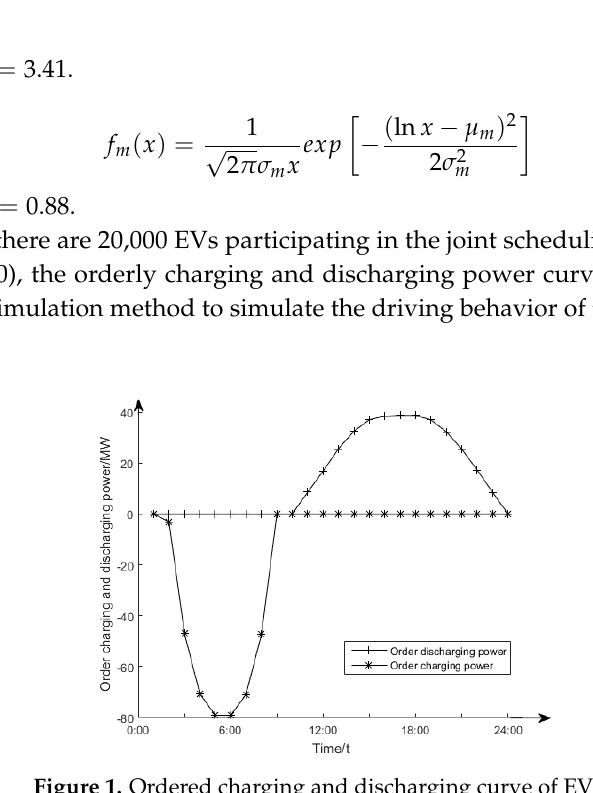
Figure 1. Ordered charging and discharging curve of EVs.